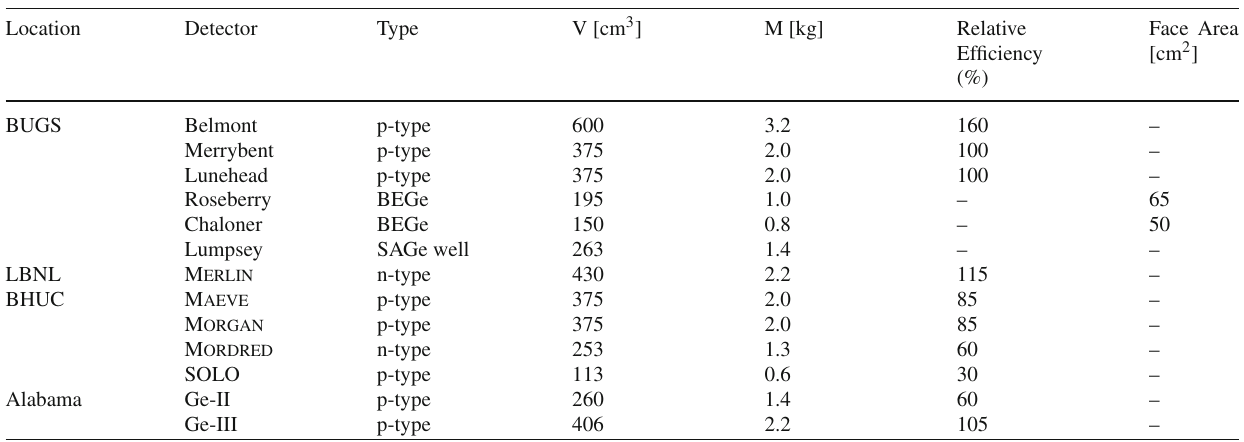
The relative efficiency and face area values quoted in